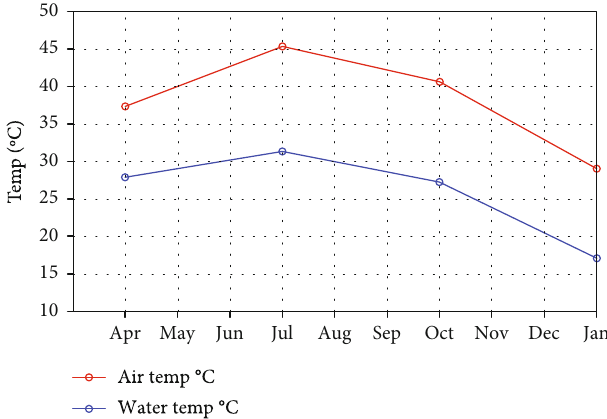
Figure 11: Lake Nasser surface temperature compared with air temperature